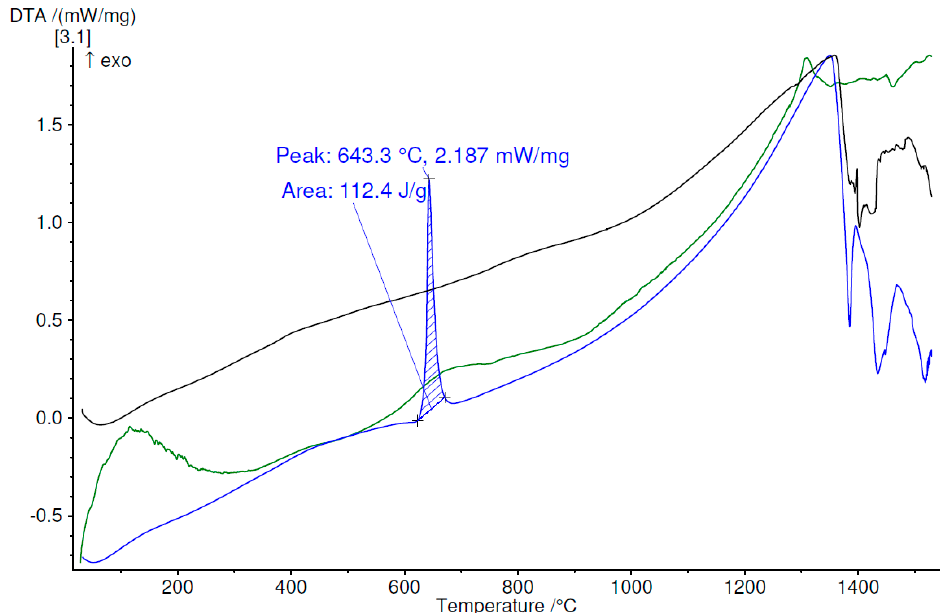
Figure 20. DTA variation as a function of temperature, up to 1530 °C, for Ti 64 Zr 10 Si 15 Nb 11 alloy, bulk (black) and melt-spun ribbons (green—MS1, blue—MS2).